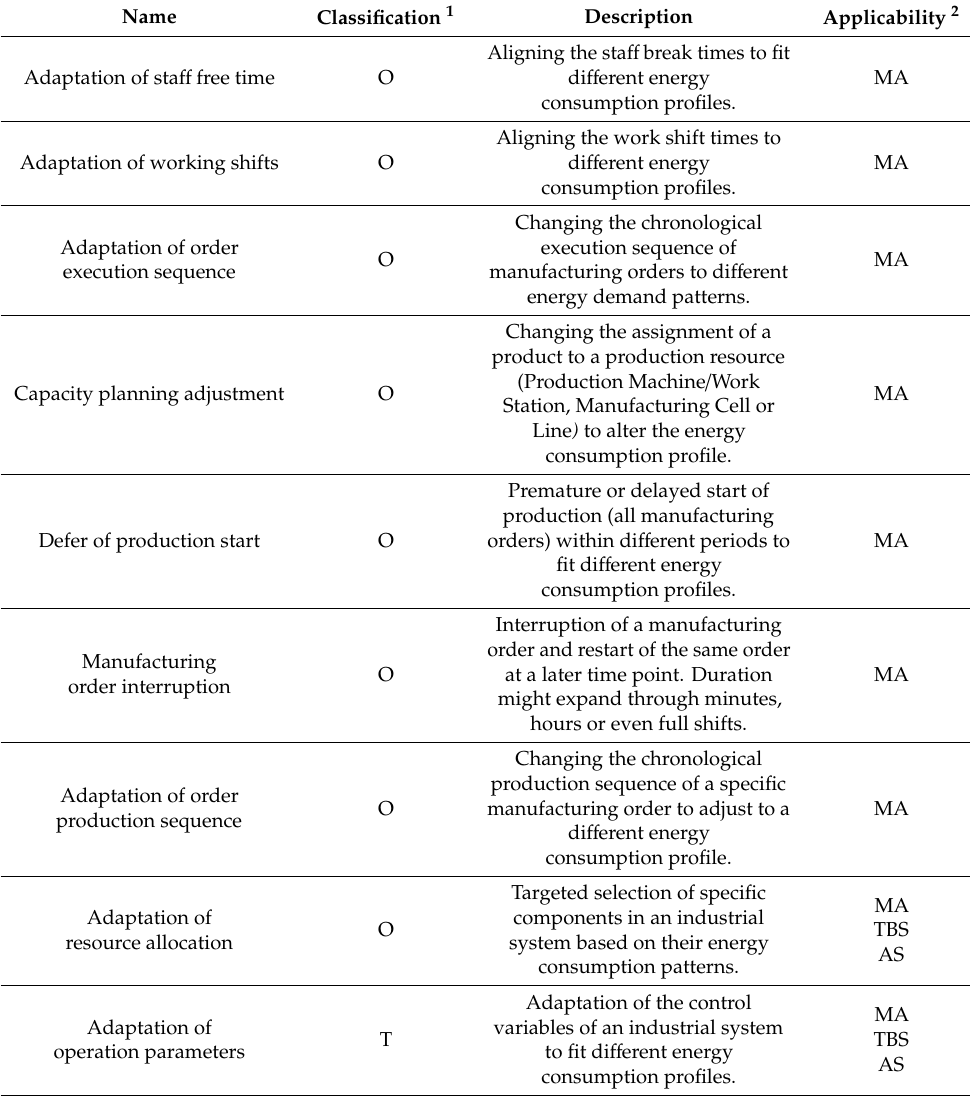
Table 1. Energy Flexibility Measure categories, classification and their applicability. Data from References